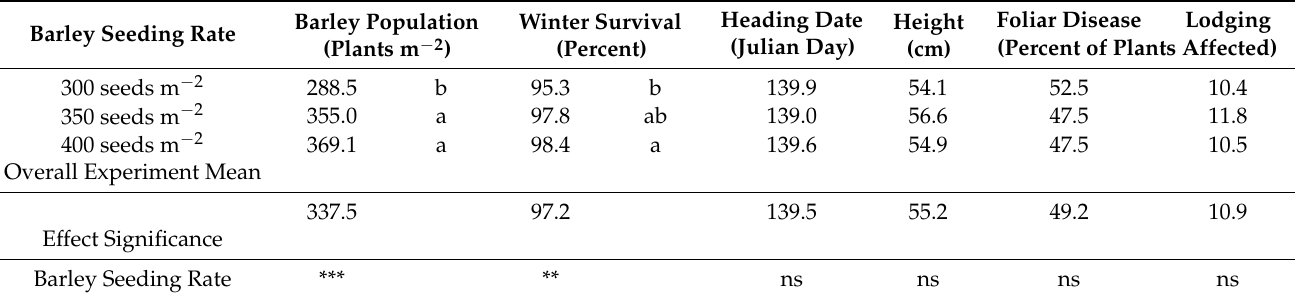
MA in 2014–2015 and 2015–2016.